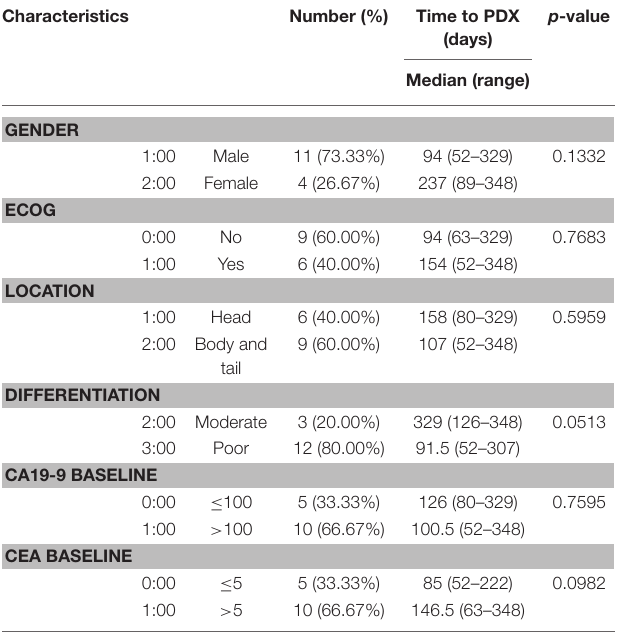
TABLE 2 | Clinicopathologic characteristics and time-to-engraftment.